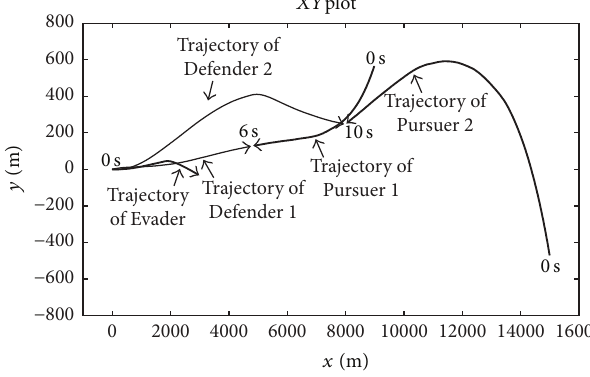
Figure 16: The trajectories of facing two